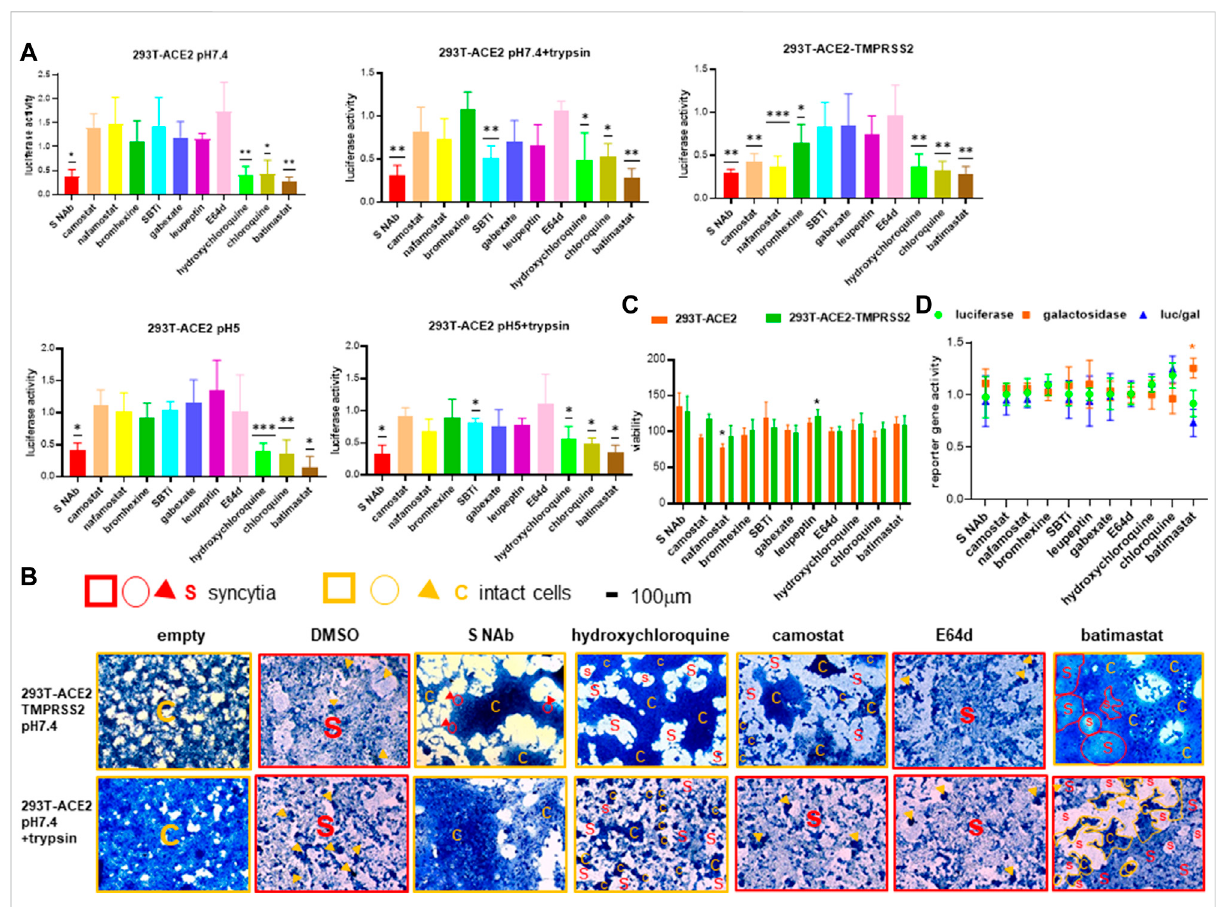
FIGURE 5 Speci fi city of different modes of fusion. (A) 19,000 target cells (293T-ACE2, 293T-ACE2-TMPRSS2) transfected with the luciferase and β -galactosidase reportergeneswerepre-incubatedwith10 μ g/mlofanti-spikemonoclonalantibody(ACROBSPD-M128),75 μ g/mlsoybeantrypsininhibitor(SBTi),10 μ g/ml leupeptinor10 μ Mofindividualdrugsbeforeco-culturedwith19,000donor293Tcellstransfectedwiththesevereacuterespiratorysyndromecoronavirus2 (SARS-CoV-2)spikeproteins(SARS-2-S)togetherwithaplasmidencodingtheT7polymerase.Theco-culturesweretreatedasindicated.Fusionactivity was measured as luciferase activity normalized against β -galactosidase activity and expressed as a ratio to the solvent control in the respective cell type and fusionconditionwhichissetas1.Dataarepresentedasmean+/-SDof > 3repeats. (B) Photomicrographsoffusioncellmorphology.50,000targetcells(293T- ACE2, 293T-ACE2-TMPRSS2) pre-incubated with 28 μ g/ml anti-spike monoclonal antibody (Sino Biol, 40592-R001) or 10 μ M of individual drugs were co- cultured with 50,000 donor 293T cells transfected with an empty vector or the SARS-CoV-2 spike protein. The co-cultures were treated as indicated.